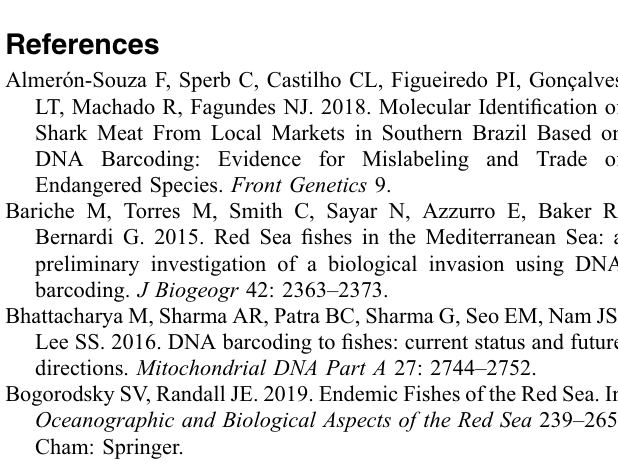
Table S1. P-distances genetic. Table S2. JK genetic distances. Table S3. K2P genetic